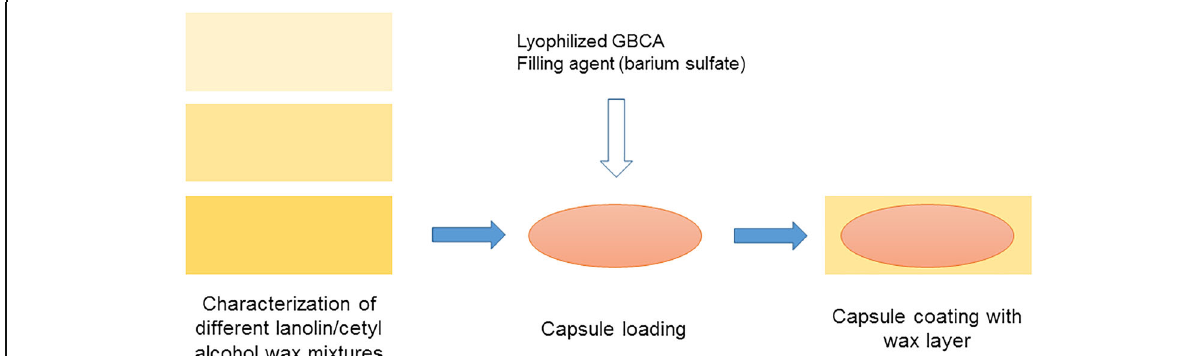
Fig. 1 Schematic depiction of the workflow yielding wax-coated capsules. Firstly, different lanolin/cetyl alcohol mixtures are analysed in terms of melting point. Secondly, empty capsules are filled with a lyophilised gadolinium-based contrast agent and a filling agent (barium sulphate). Thirdly, the capsules are coated with the wax mixture